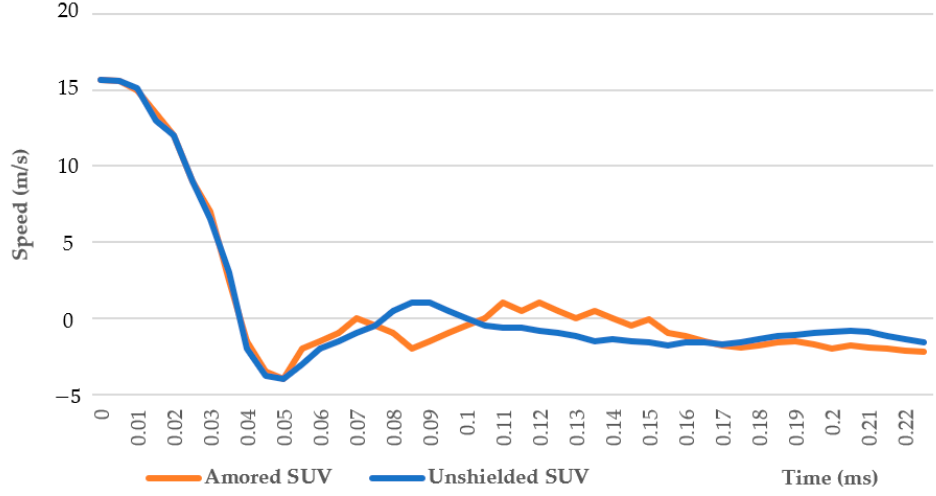
Figure 14. Behavioral speed of the dummy in the unshielded SUV vs. the armored SUV.